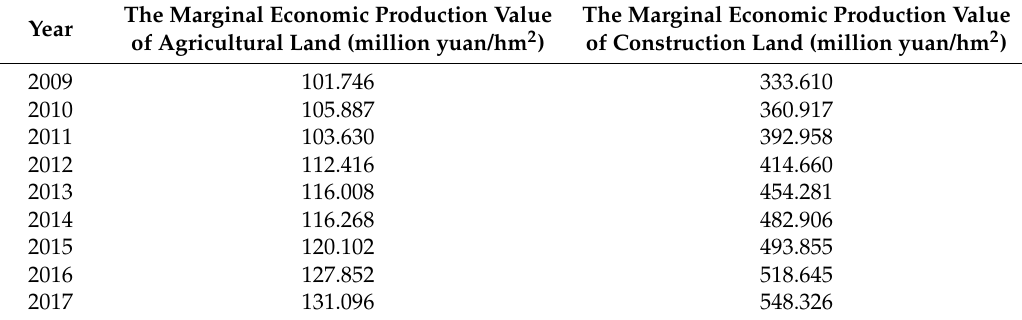
The Marginal Economic Production Value of Construction Land (million yuan/hm 2 )